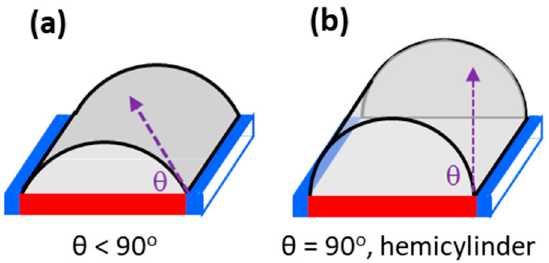
Figure 1. Schematic of droplets produced by de ‐ wetting of a liquid on a surface patterned with narrow hydrophilic/hydrophobic stripes. Blue = hydrophilic/high ‐ energy surface. Purple = hydro ‐ phobic/low ‐ energy surface. Contact angles θ ( a ) < 90°, ( b ) =90°.